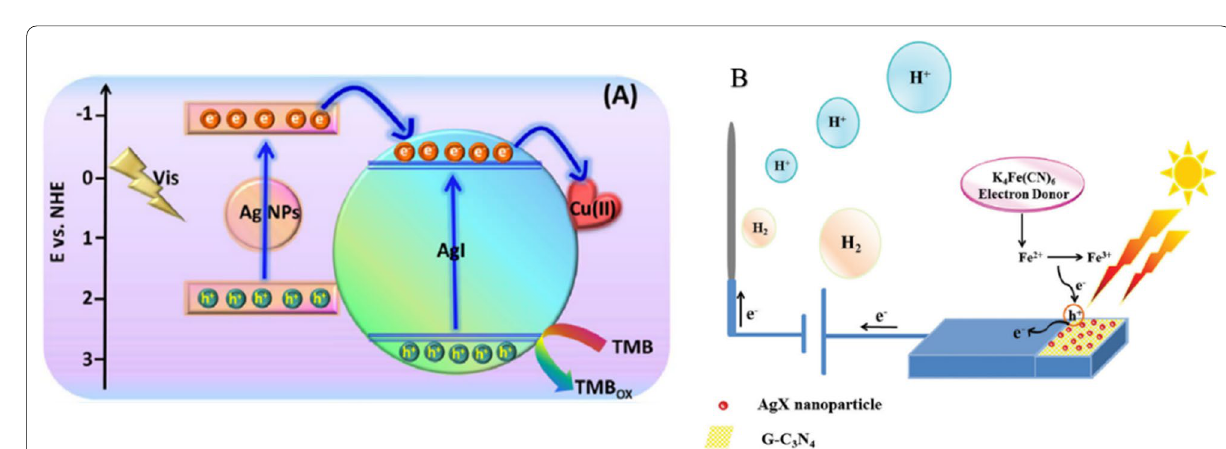
Fig. 6 A The schematic illustration of oxidation of TMB by Cu 2 + /Ag–AgI B Photo-generated electron–hole transfer mechanism of C 3 N 4 –AgX in the presence of 0.1 M K